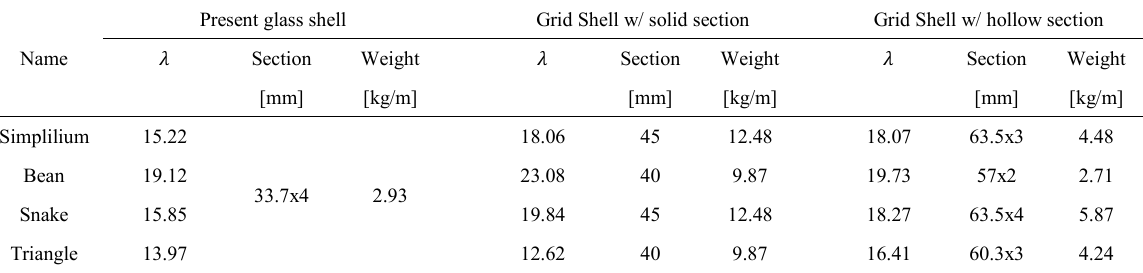
Table 3: Cross-section properties of grid shell with comparable buckling multiplier.